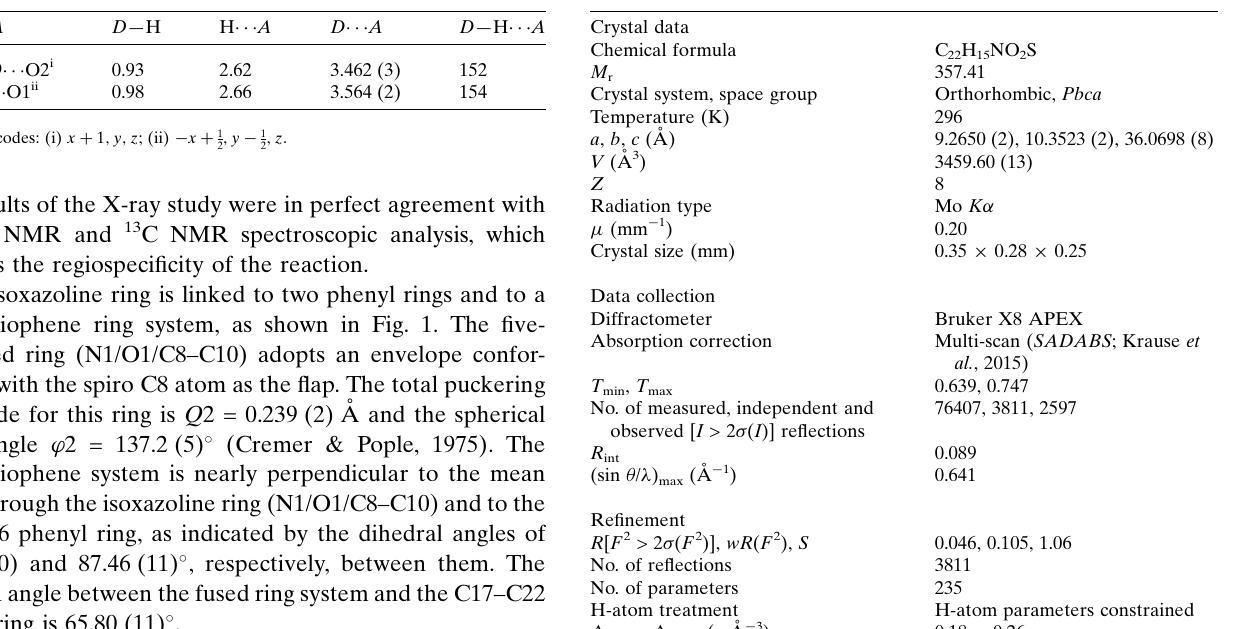
Table 1 Hydrogen-bond geometry (A˚ , (cid:2) ).